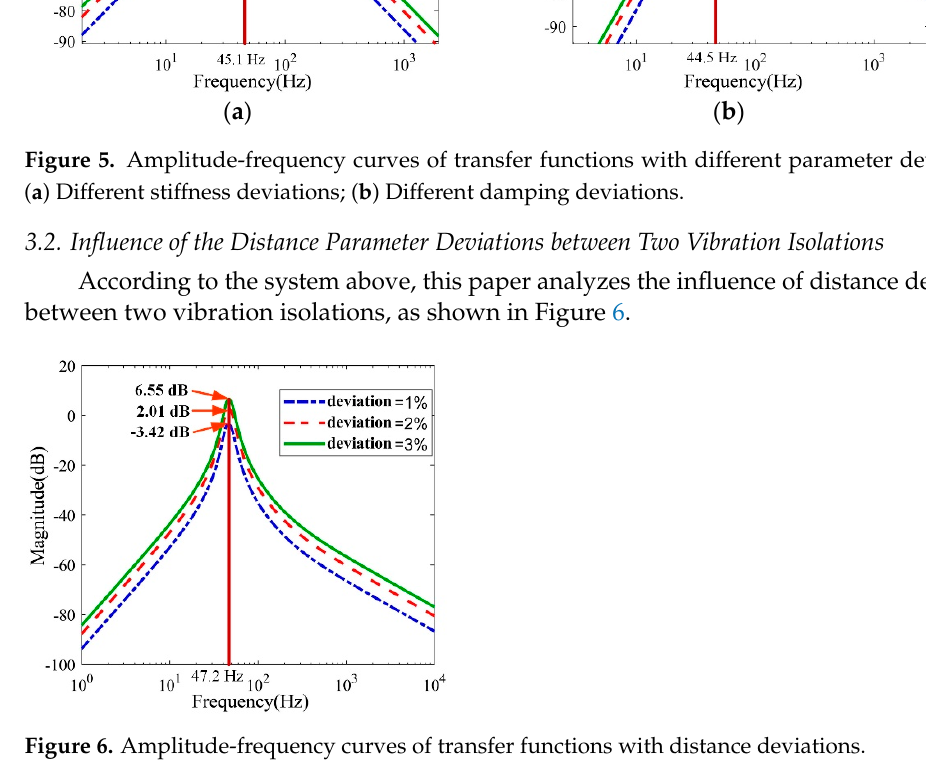
Figure 5. Amplitude-frequency curves of transfer functions with different parameter deviations. ( a ) Different stiffness deviations; ( b ) Different damping deviations.